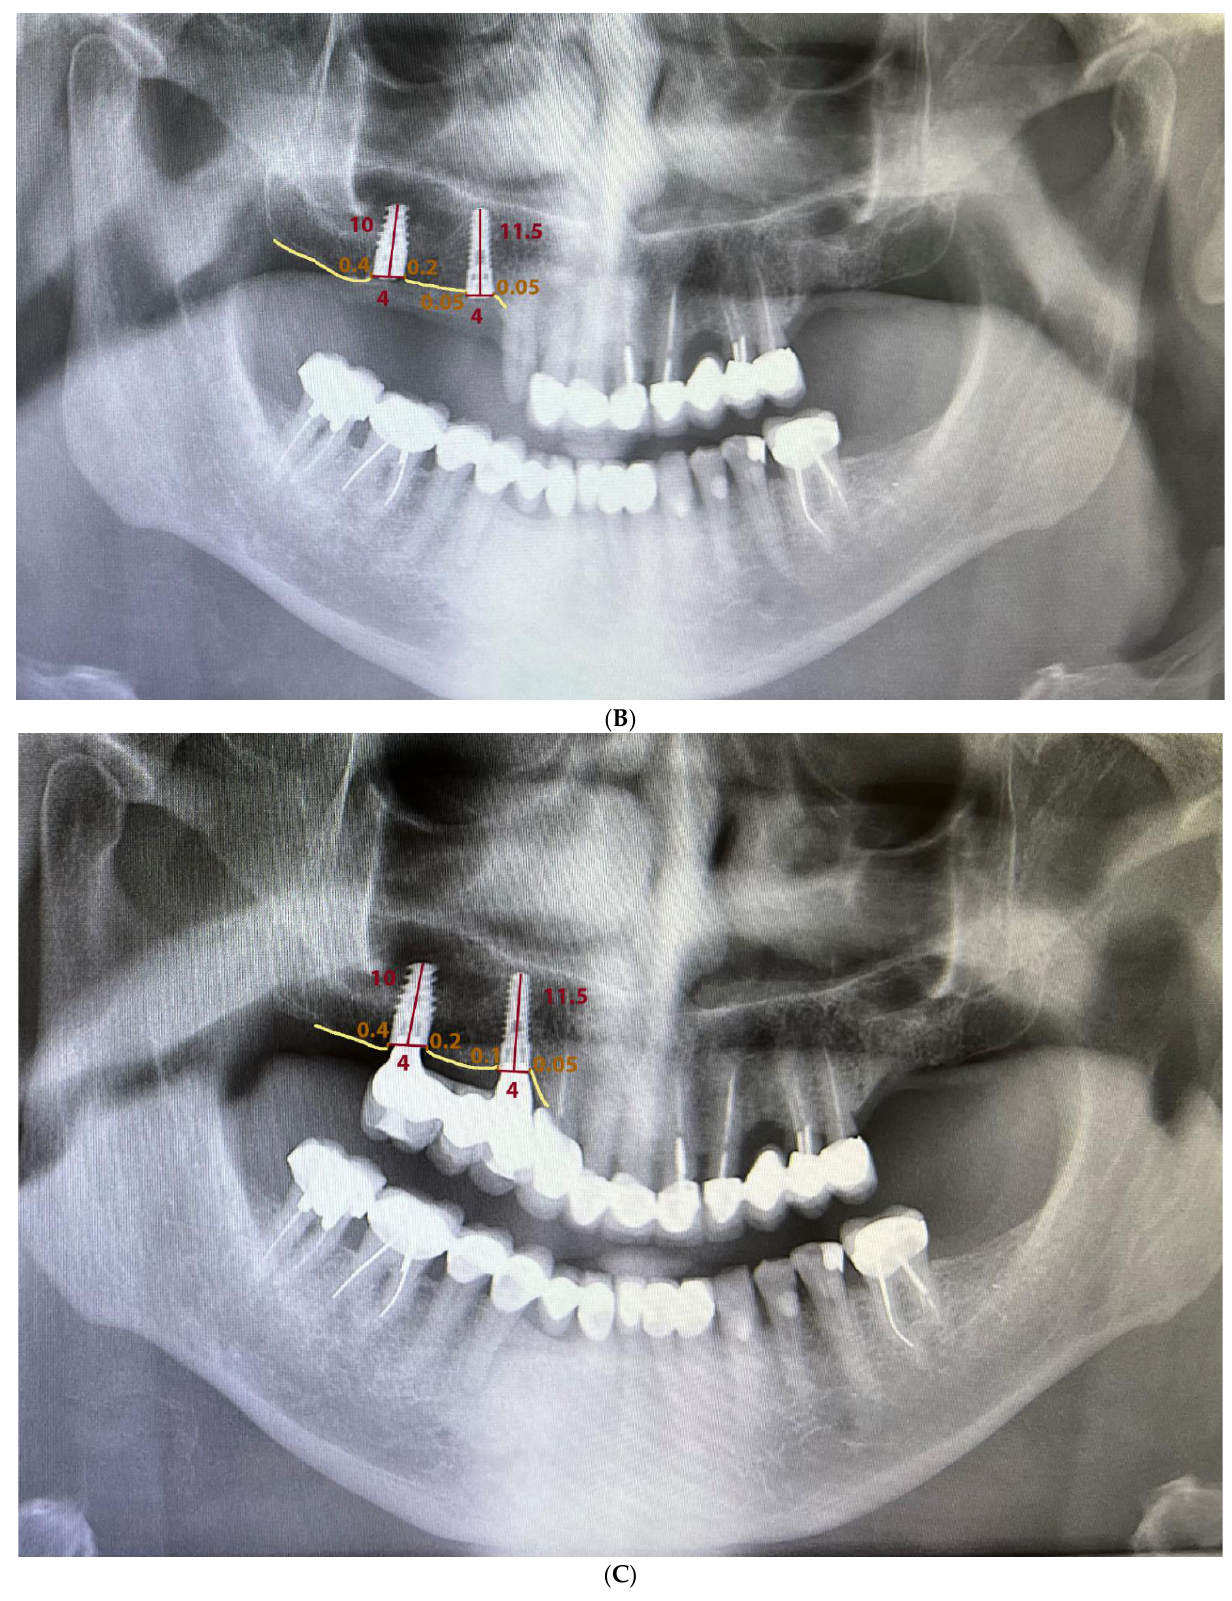
Figure 2. Measurement of peri-implant bone loss: ( A ) after implant placement, ( B ) after 1 month, and ( C ) after 4 months.